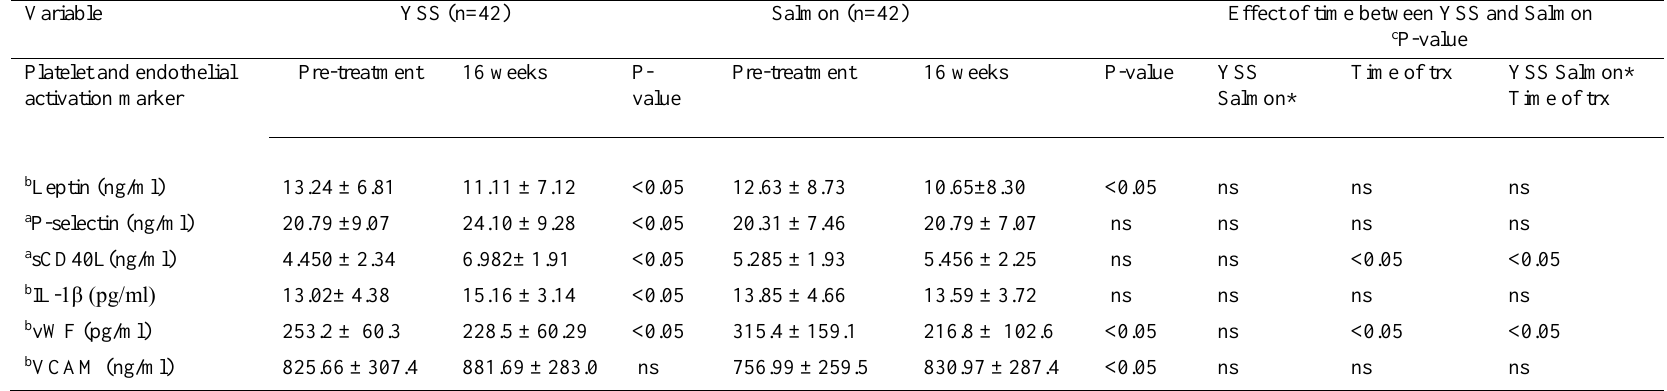
Table 2: Changes in platelet and endothelial activation biomarkers after intervention period (16 weeks) within and between YSS and Salmon diet groups